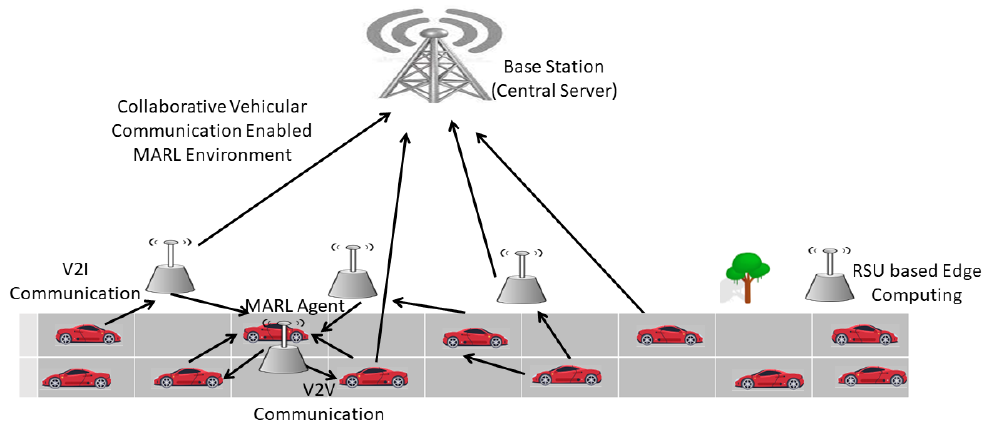
Figure 9. Vehicular-communication-based collaborative MARL